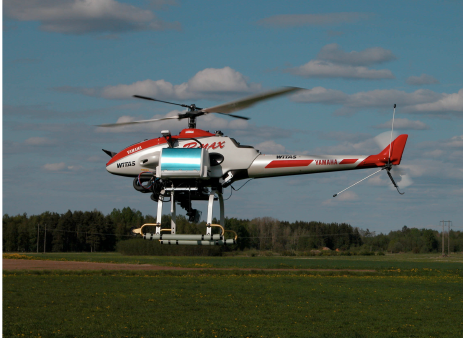
Figure 1: The Yamaha Rmax UAV